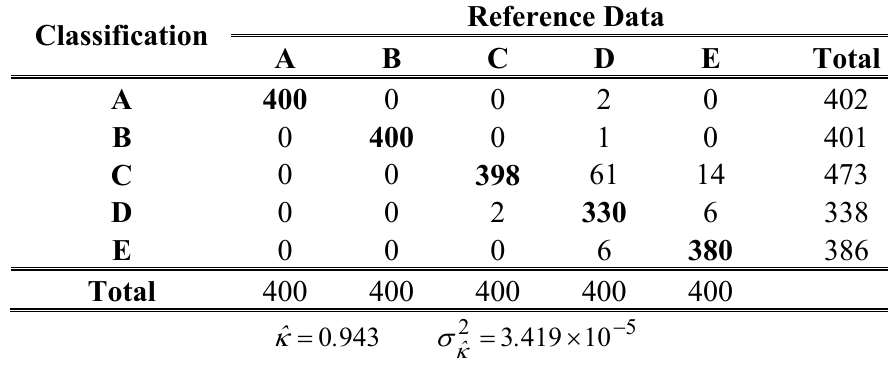
Table 6. Confusion matrix (# of pixels) using the bivariate HH-VV distribution (L-Band).